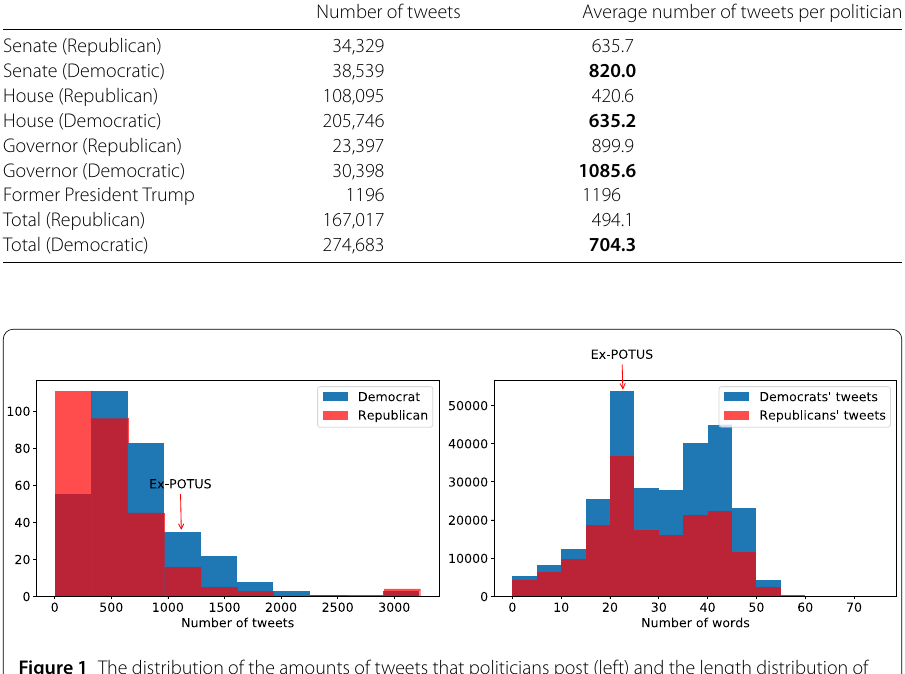
Table 1 The number of tweets posted by each group of politicians and the average number of tweets posted per person